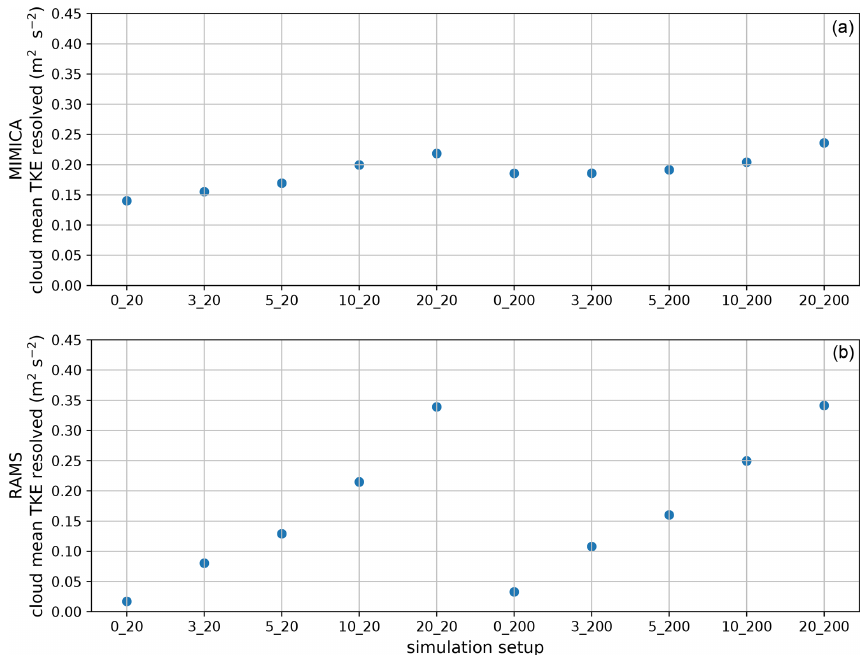
Figure A6. Time mean resolved turbulent kinetic energy (TKE) averaged for the cloud layer, simulated by MIMICA and RAMS. For figure clarity, the plot titles have been abbreviated; the first number refers to the accumulation mode and the second to the Aitken mode concentration in cubic centimetres, i.e. 0_20 refers to AC0_AK20.